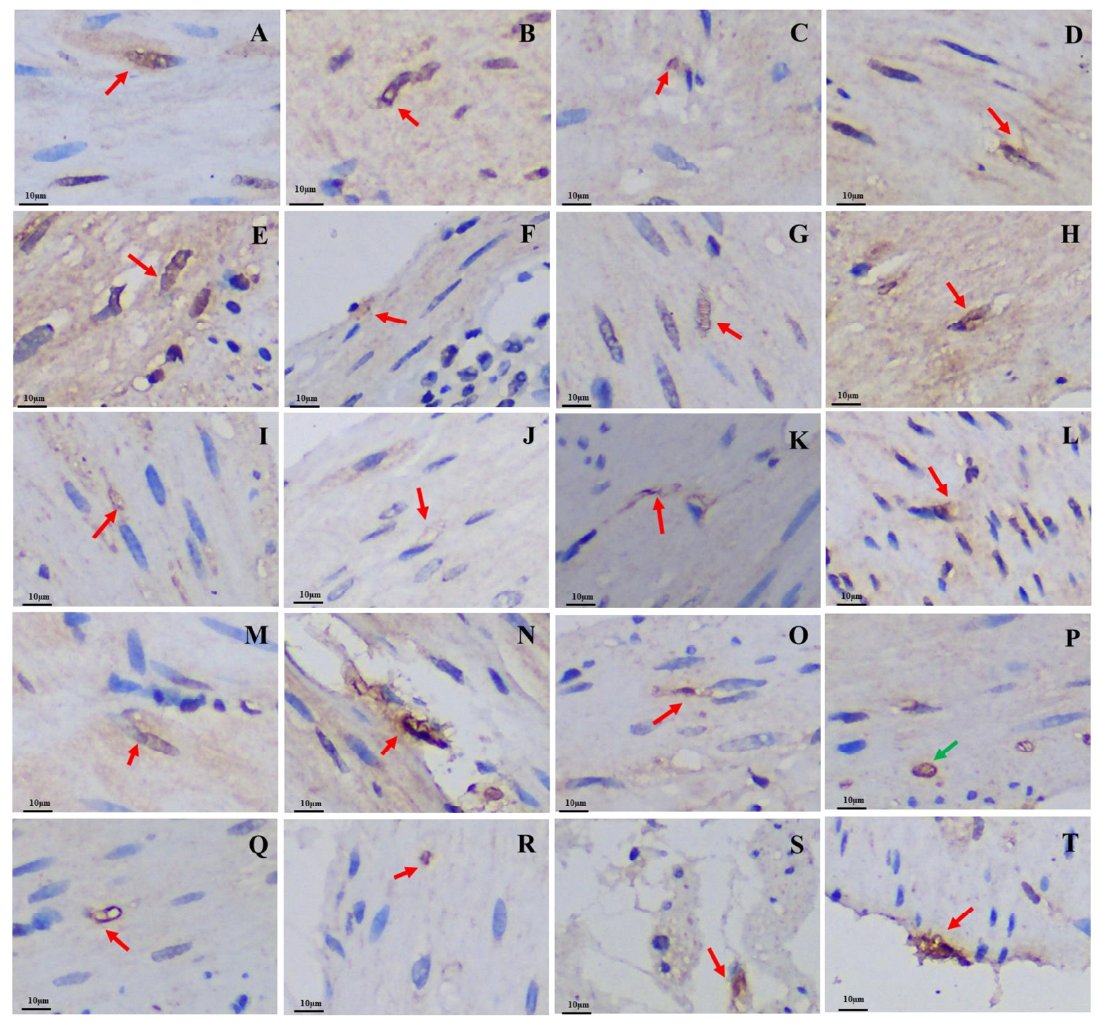
Figure 4. Distribution and morphology of 5-HT-immunoreactive cells in the GIT of the plateau zokor and plateau pika (400 × magnification). ( A – J ) Followed by the fundus of stomach, corpus I of stomach, corpus II of stomach, pylorus of stomach, duodenum, jejunum, ileum, colon, rectum, and cecum of the plateau zokor; ( K – T ) similarly, the plateau pika’s gastrointestinal organs. The red arrow indicates opened-type argyrophilic cells and the green arrow indicates closed-type argyrophilic